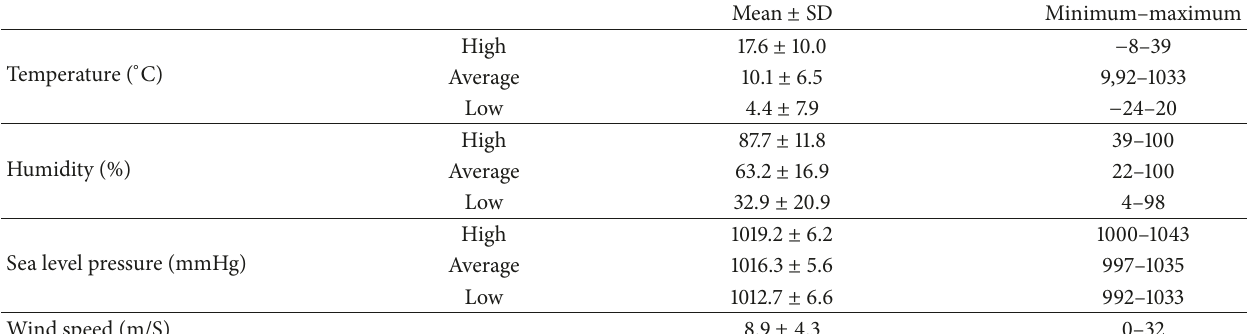
Table 1: Descriptive statistics of temperature parameters.